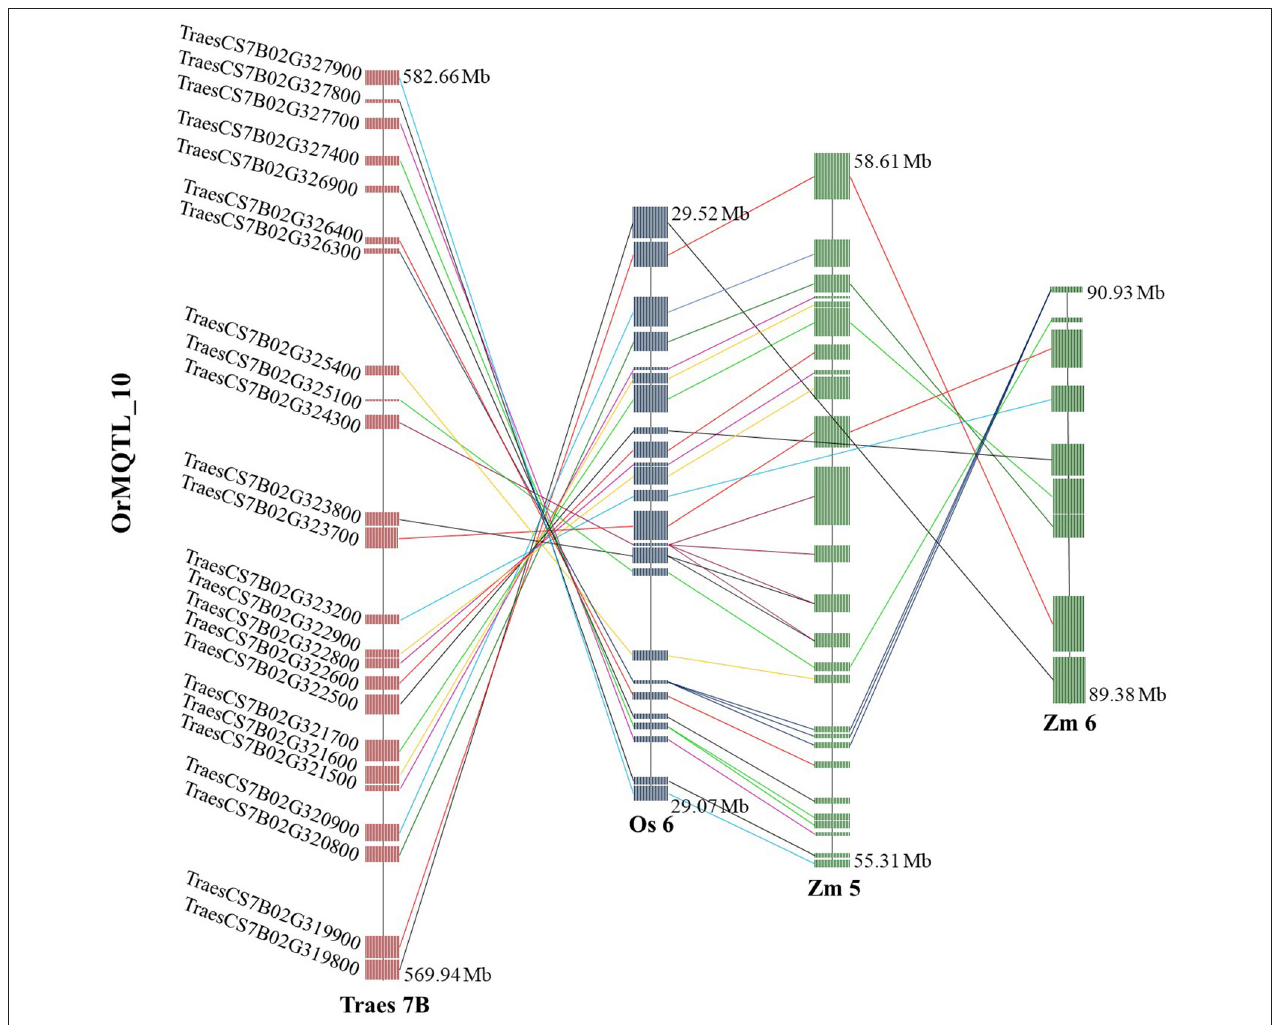
FIGURE 7 | The syntenic region of meta-quantitative trait loci (MQTLs) among the wheat, rice, and maize. Orthologous MQTL (OrMQTL)_10 indicates syntenic regions among identified MQTLs for grain yield (GY) control in wheat (MQTL_7B_3), rice (MQTL-YLD14), and maize (MQTL5.5 and MQTL66). The genomic position, chromosome number, and common genes among the wheat, rice, and maize are